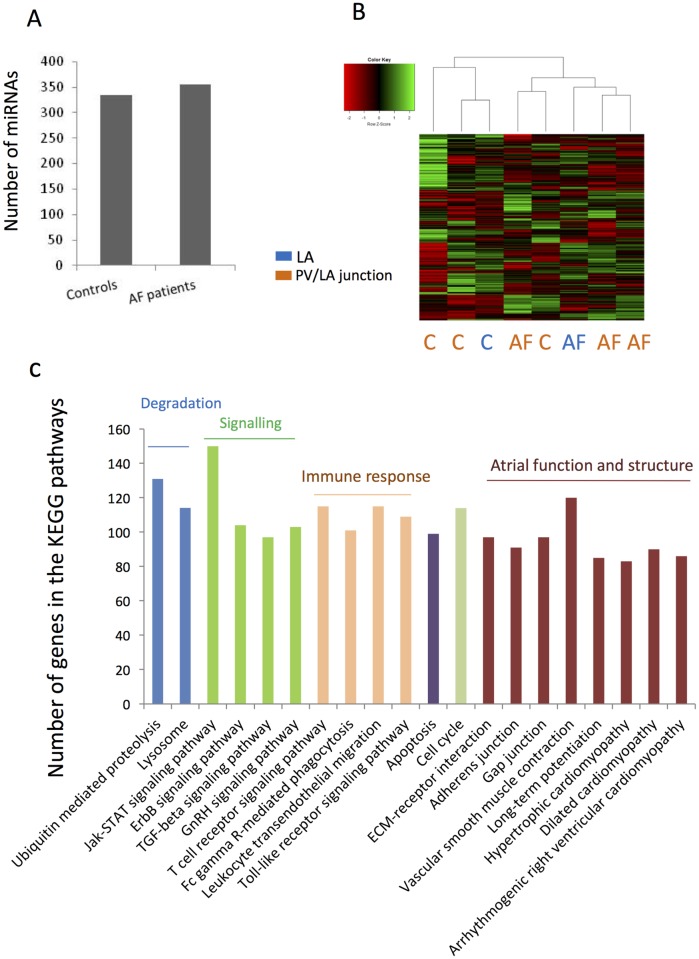
miRNA expression in human left atria (LA) from patients suffering from valvular heart disease (VHD patients) associated with atrial fibrillation (AF patients) or without AF (controls).A) Number of miRNA expressed in LA from controls or AF patients. B) Unsupervised hierarchical clustering and heat-map of the 299 miRNA basal expressions, expressed in all VHD patients. LA = biopsies from LA; PV/LA = biopsies from pulmonary vein-LA junction. C) Significantly enriched KEEG pathways (BABELOMICS analyses) with target genes of the 299 miRNAs (prediction from TARGETSCAN). Only pathways containing more than 50 predicted genes were considered.